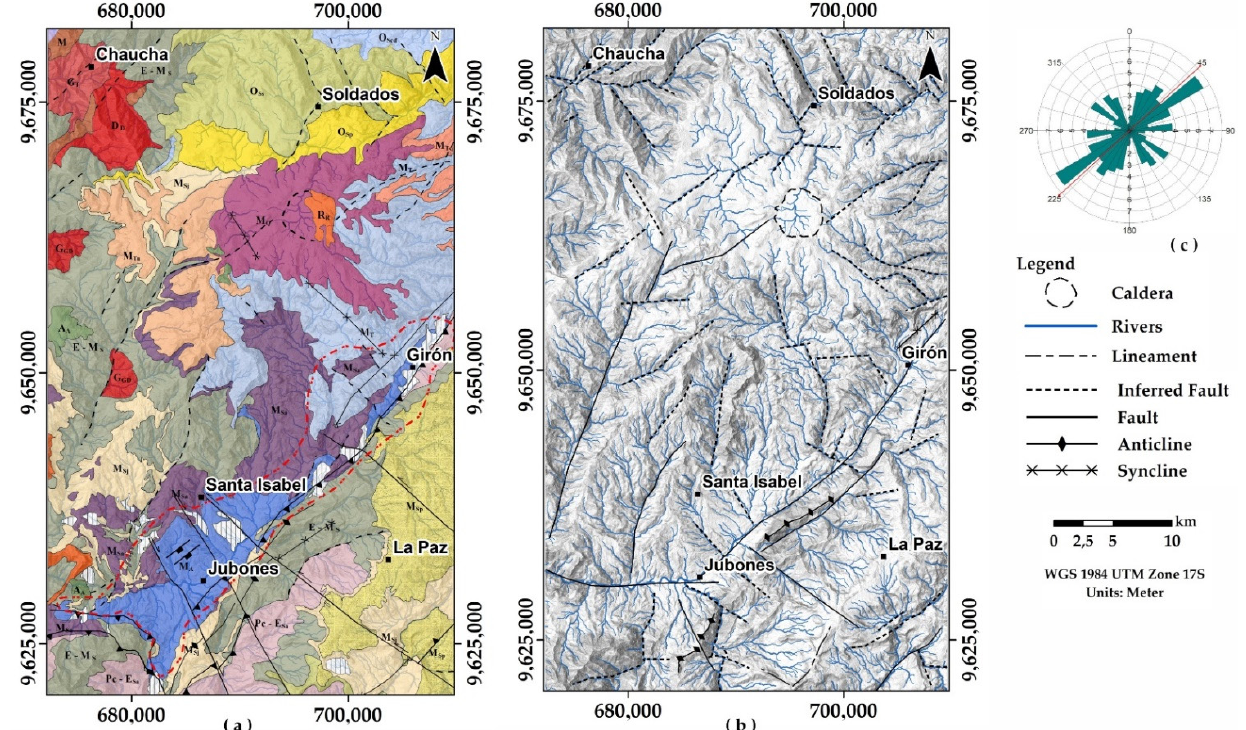
Figure 13 . ( a ) Geological map of the area. ( b ) Structures obtained from the study area. ( c ) Rose diagram of inferred faults in the studied area. The legend of the geological map is shown in Figure 3.